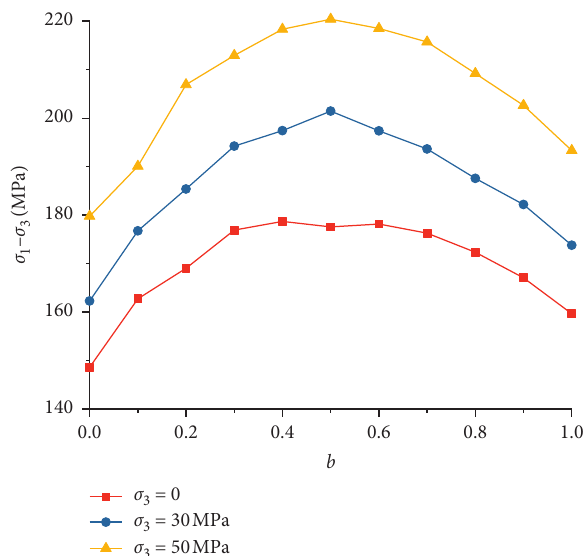
Figure 5: Peak stress curves with different intermediate stress ratios.